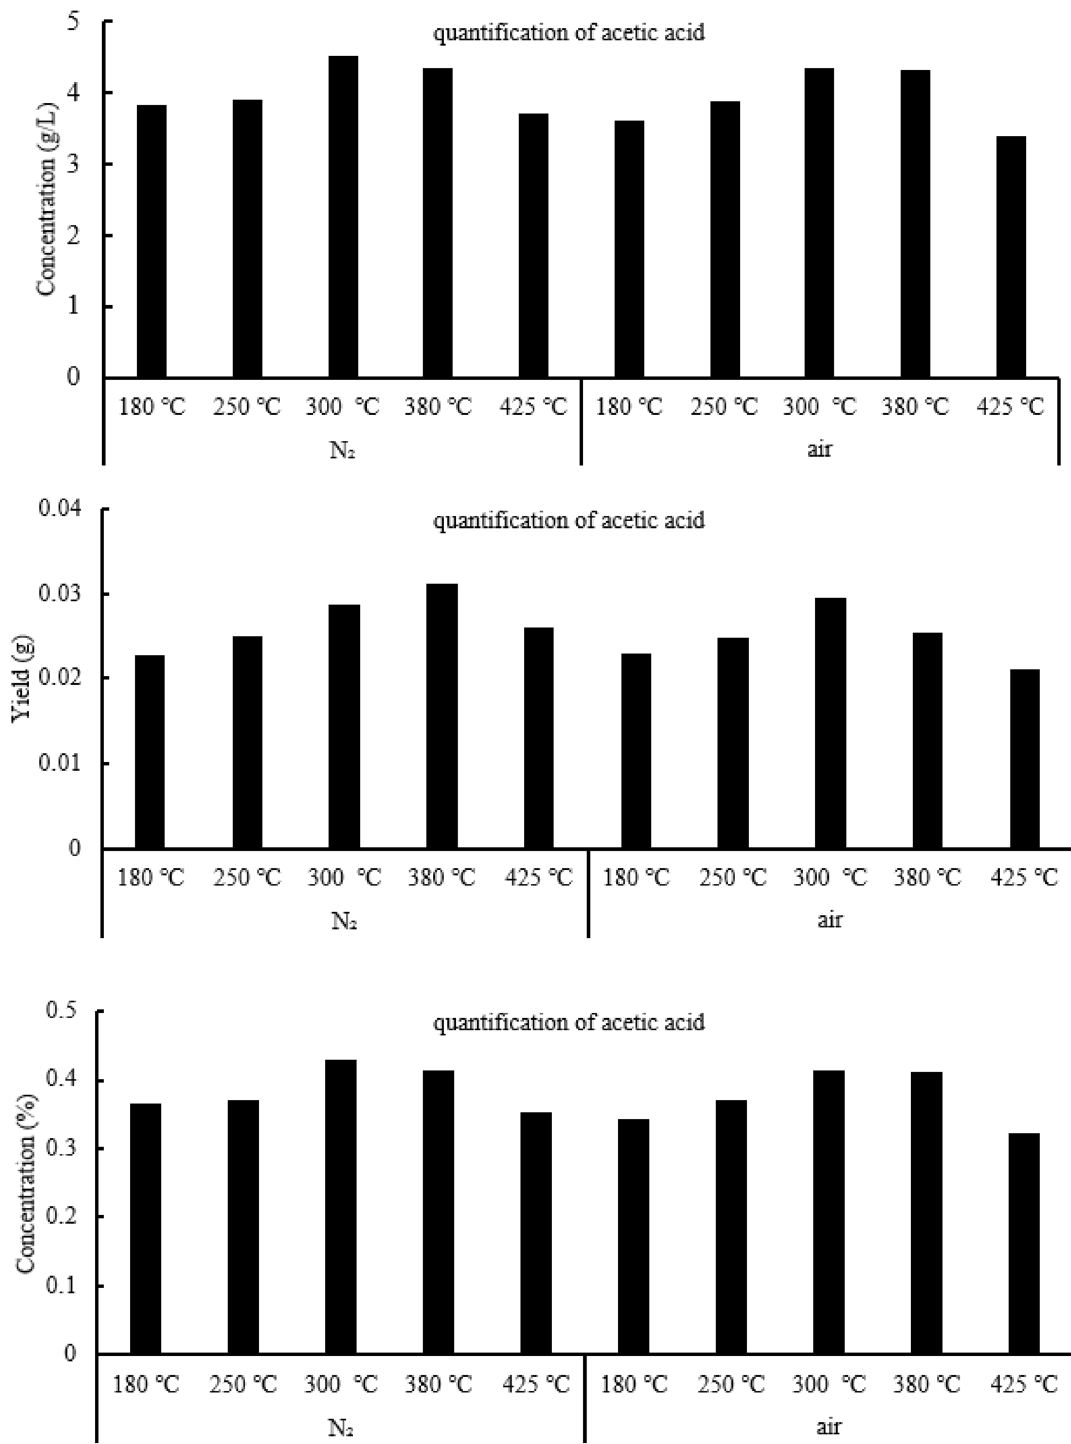
Fig. 7 Quantification of acetic acid by its measured concentration (top; SD < 0.0501) and yield (bottom; SD <